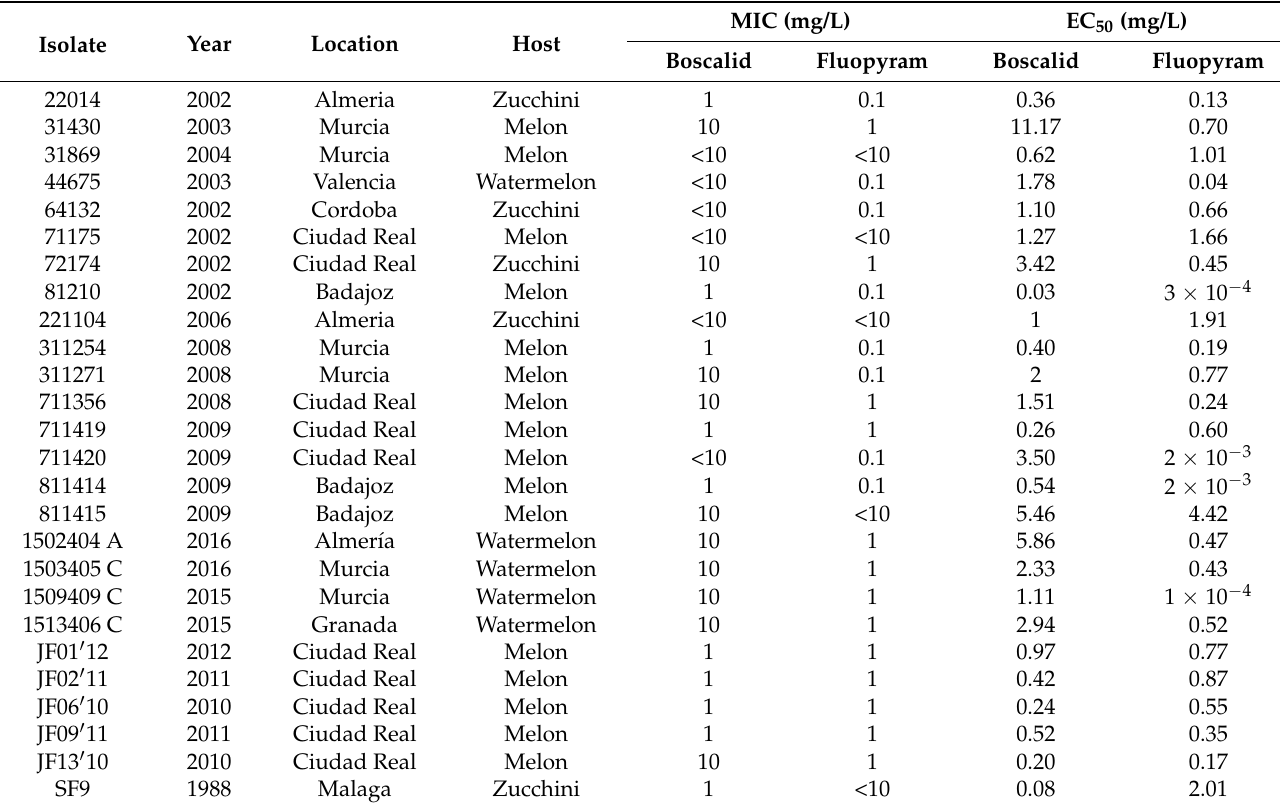
Table 1. Sensitivity of 26 randomly chosen Podosphaera xanthii isolates to the SDHI fungicides boscalid and fluopyram. The values of the minimal inhibitory concentration (MIC) and concentration inhibiting 50% of the growth (EC 50 ) are shown.